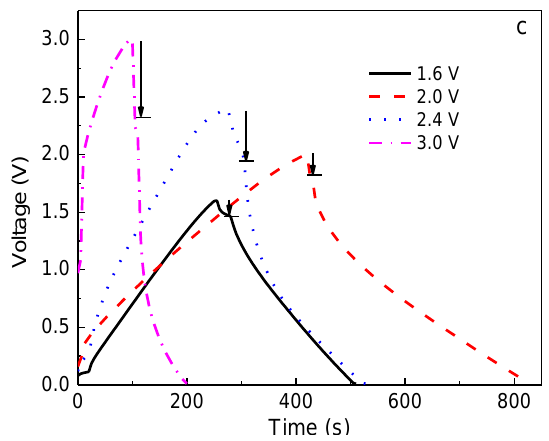
Figure 7. ( a ) Cyclic voltammetry curves at a scan rate of 5 mV s − 1 , ( b ) charge-discharge curves of 1st cycle, and ( c ) charge-discharge curves of 100th cycle, for the electric double layer capacitor (EDLC) fabricated with the P-40-10 electrolyte system, performed at a current density of 0.4 A g − 1 under different working voltages.